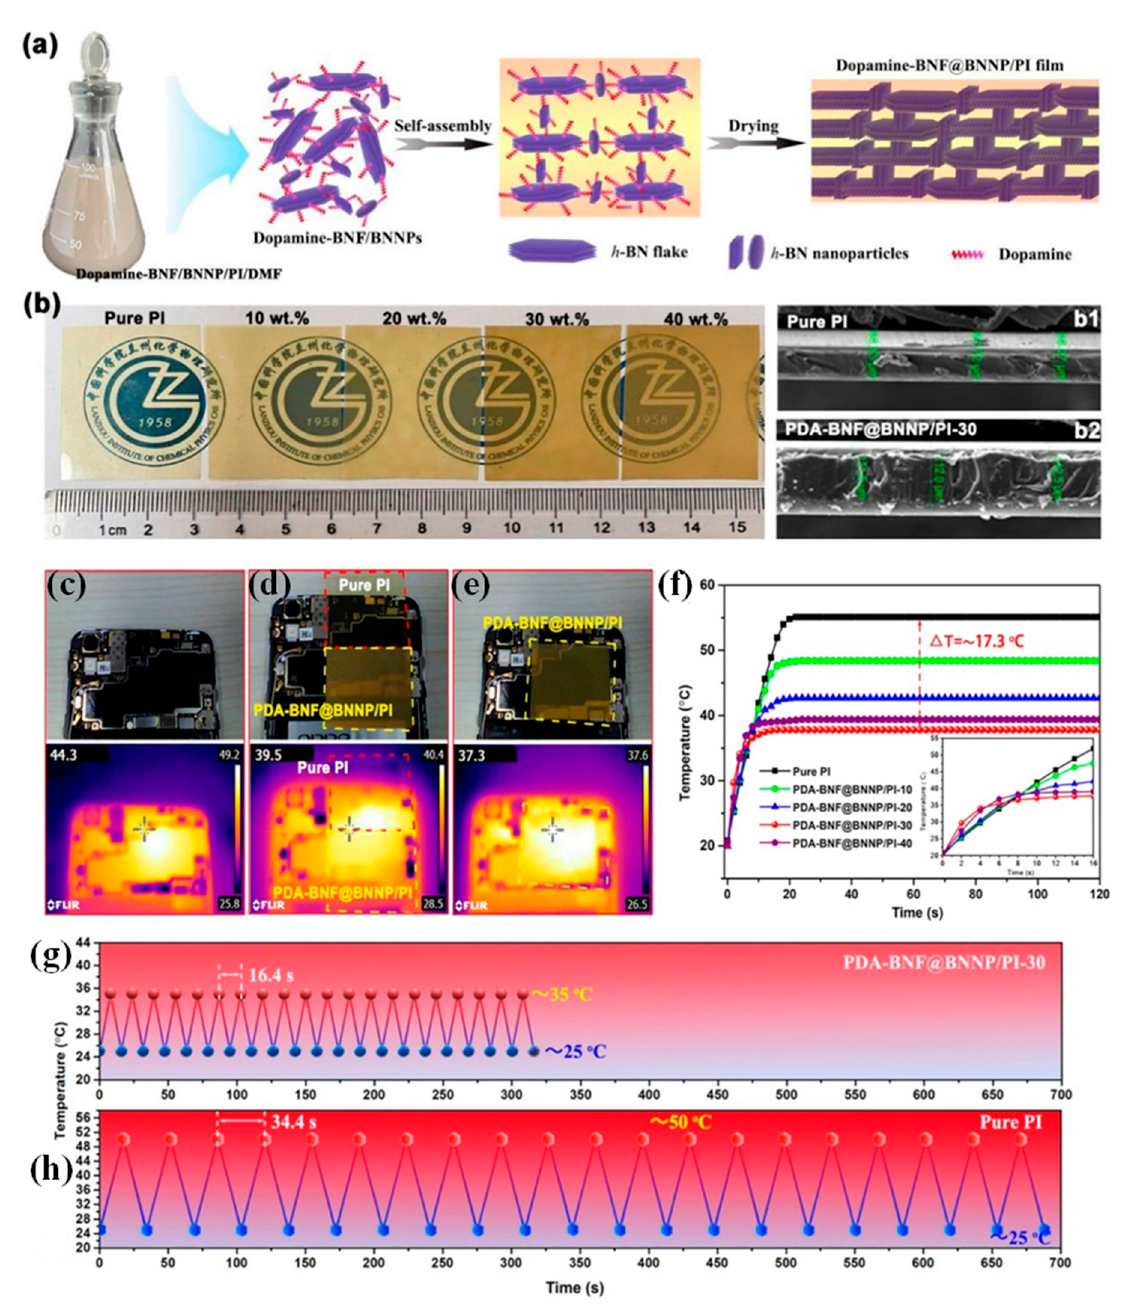
Figure 16. ( a ) A schematic for preparing PDA-BNF@BNNP/PI composite films. ( b ) The transparency of composite films with different contents of PDA-BNF@BNNPs. Including cross-section SEM images of two types films. Thermal infrared images of a running mobile CPU core ( c ) without films, ( d ) covered by composite films, ( e ) covered by PI (up), and covered by composite (down) films. ( f ) Temperature dependence on running time of a mobile CPU core covered by composite films with different contents. Temperature variations of ( g ) PI films and ( h ) composite films during cyclic states. Reprinted with permission from Ref. [152]. 2022,